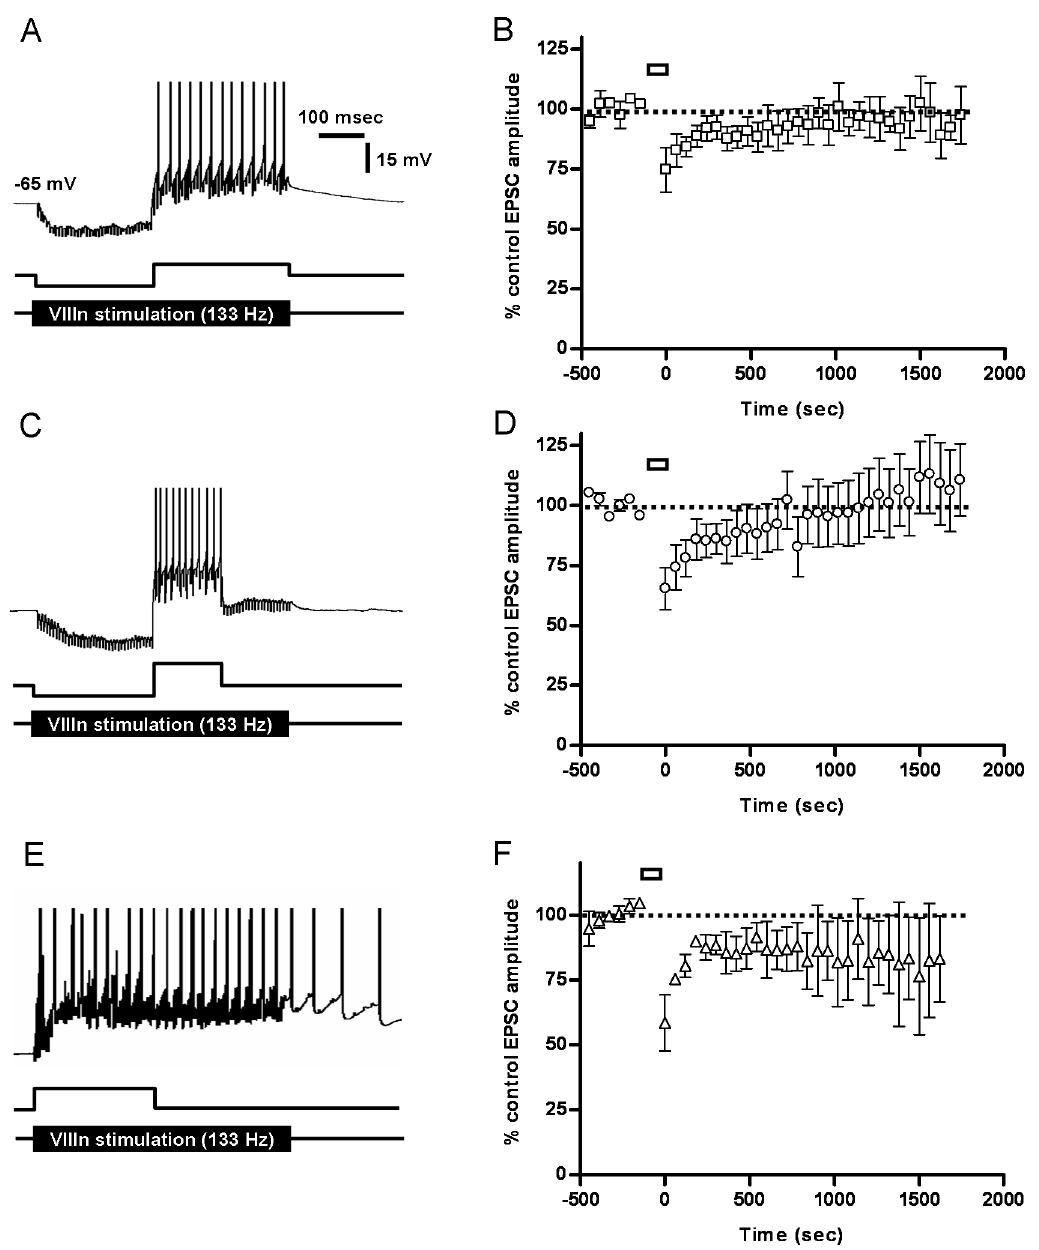
Figure 6. Post-inhibitory ‘‘rebound’’ depolarizing pulses occlude LTD at the vestibular afferent synapse induced with the PR protocol. A, Post-inhibitory membrane depolarizing pulses with a duration and amplitude equal to the inhibitory pulse (A, C) or with a duration of half that of the hyperpolarizing pulse but double its amplitude (B, D) occluded the expected LTD at the vestibular afferent synapse in response to the PR protocol, so that no long-term depression was induced (C, p=0.6 compared to control, n=4; D, p=0.9 compared to control, n=7). An alternative protocol where a depolarizing pulse was combined with vestibular nerve stimulation (E), also induced a short-term depression with no lasting significant change in EPSC amplitude (F; p=0.2 compared to control, n=3). Action potentials are truncated in A, C and E.